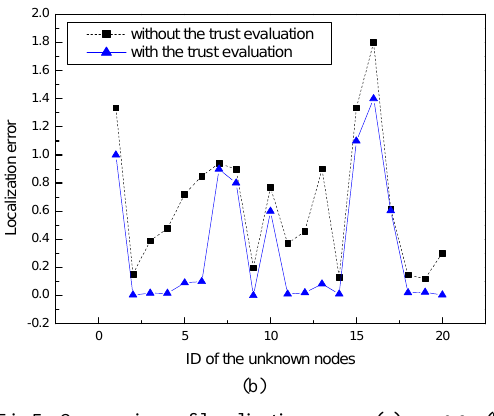
Fig.5. Comparison of localization errors: (a) 0.3